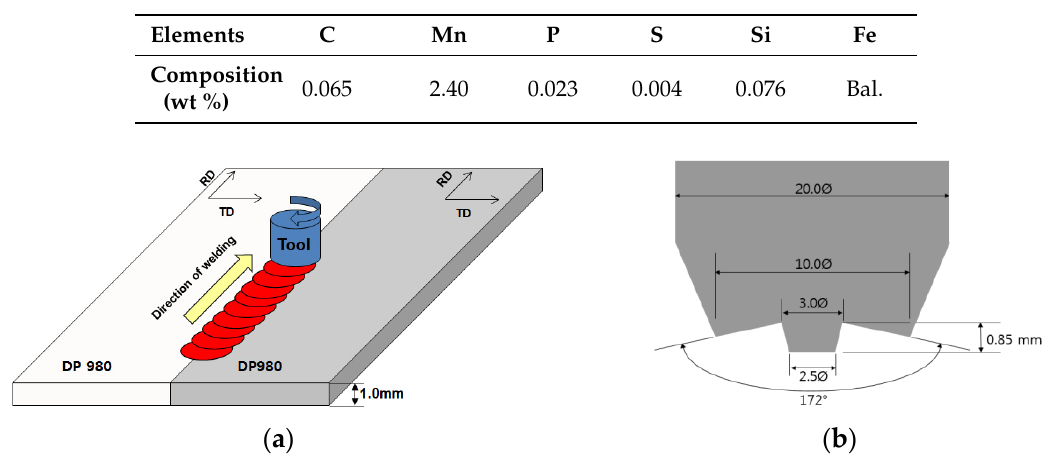
Figure 1. Friction ‐ stir ‐ welding (FSW) of DP980 steel sheet: ( a ) schematic description of FSW process; ( b ) details of cylindrical tool used in FSW process. RD: rolling direction; TD: transverse direction . Table 2. FSW parameters used for DP980.